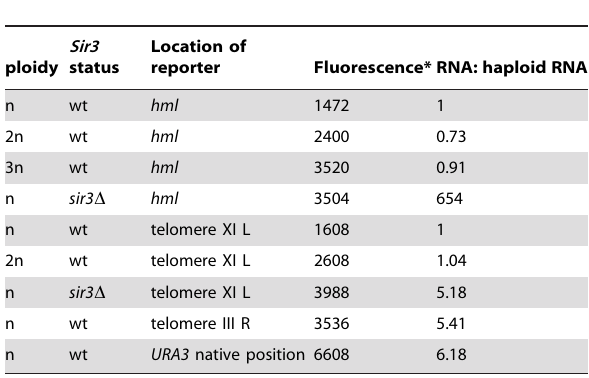
Table 2. Level of reporter fluorescence measured by flow cytometry and RNA level as ratio to that in haploid